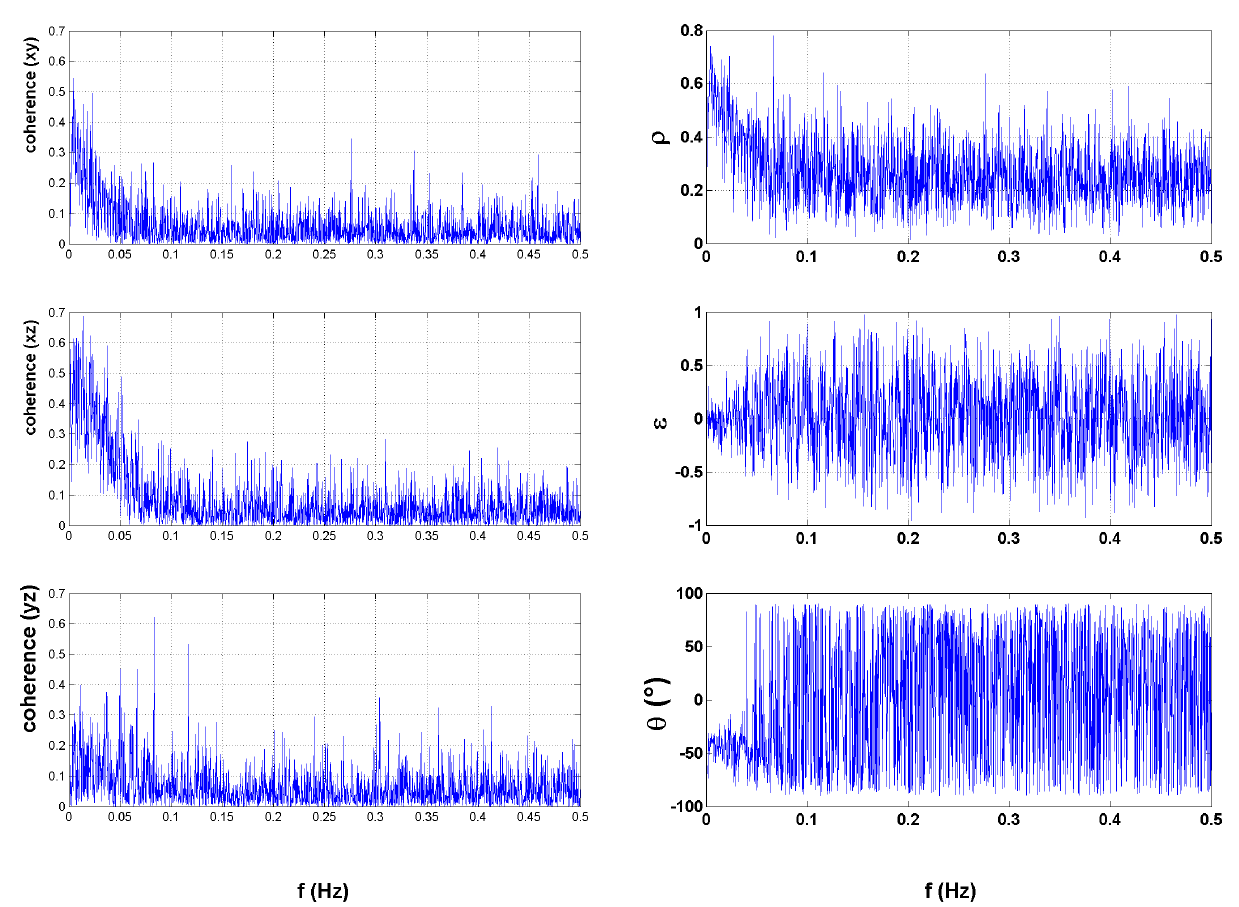
Figure 10. Polarization analysis of the horizontal components of geomagnetic